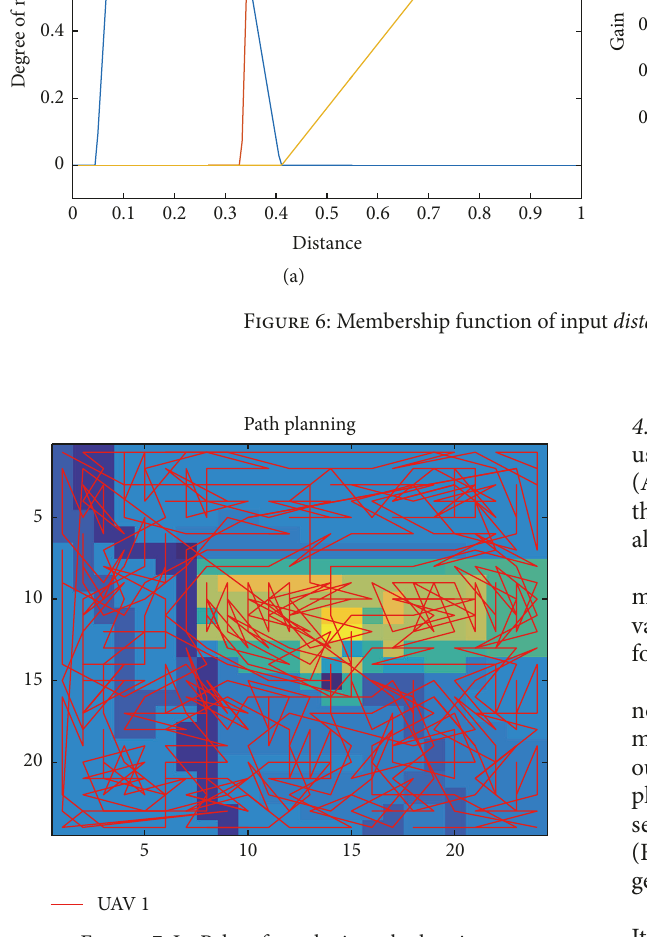
Figure 7: La Palma fuzzy logic path